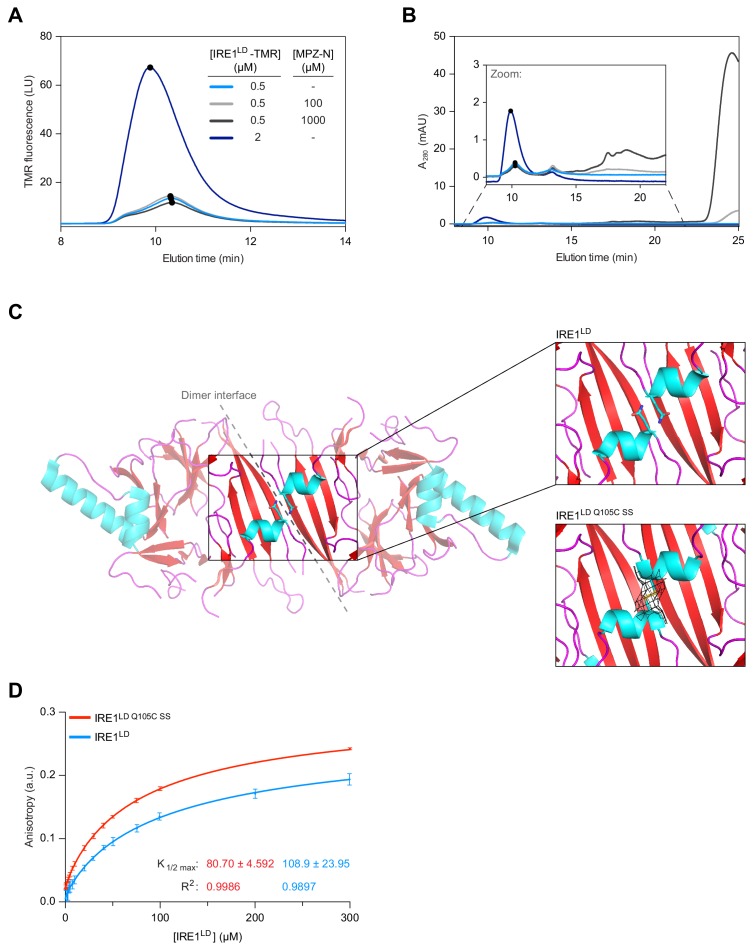
Binding of MPZ-N peptide to IRE1LD does not promote IRE1LD dimerisation.(A) Size-exclusion chromatography (SEC) elution profiles of TAMRA (TMR)-labelled wild-type IRE1LD at the indicated concentrations in presence and absence of MPZ-N peptide. TMR fluorescence is plotted against elution time (see: Figure 2—source data 1). (B) SEC elution profiles (as in ‘A’), but with protein absorbance at 280 nm (A280) plotted against elution time. The inset is a zoom into the segment of the chromatogram encompassing the IRE1LD proteins, whose absorbance is dwarfed by the peak of free peptide (eluting at ~24 min). The heterogenous peaks eluting between 15 and 20 min in the sample loaded with 1 mM MPZ-N peptide, likely reflected peptide oligomerisation (see: Figure 2—source data 1). (C) Cartoon representation of the IRE1LD dimer (PDB: 2HZ6) is shown on the left with coloured secondary structures (cyan for helices, red for sheets and magenta for loops). The Gln105 side chain is shown as sticks, a closer view of which is shown on the top right. The bottom right panel shows a similar view of the Gln105Cys mutant (crystallised here), which forms a disulphide bond, covered with clear electron density (black mesh represents the 2mFo − DFc map, contoured at 1.0 σ, including density within 2 Å of the cysteine residues). (D) Anisotropy of FAM labelled MPZ-N peptide (100 nM) in presence of increasing concentrations of either wild-type IRE1LD or disulphide-linked dimeric IRE1Q105C SS. Shown are data from three independent experiments (mean ± SD). Curve fitting was performed in Prism GraphPad 7.0 using Equation 2 in Materials and methods (see: Figure 2—source data 2).Figure 2—source data 1.Source data for Figure 2A and B.Figure 2—source data 2.Source data for Figure 2D.